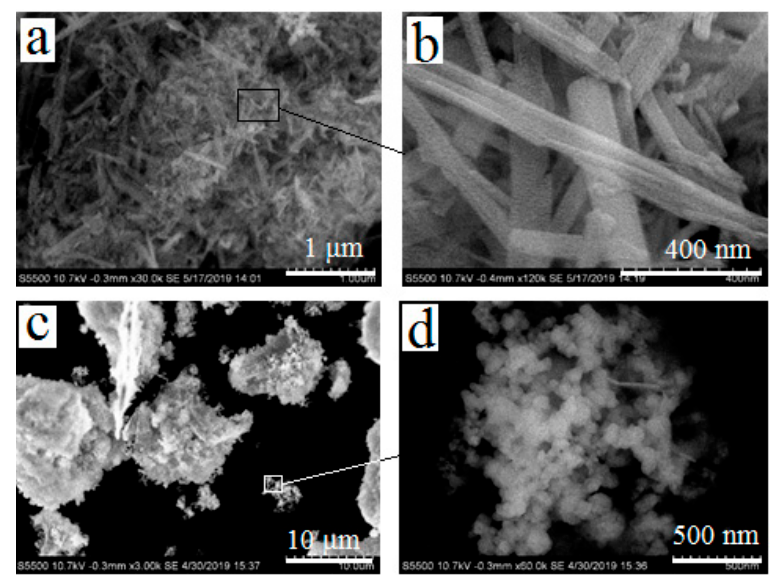
Figure 2. Powders of calcium silicate ( a , b ) and lead silicate ( c , d ) after drying at 85 °C. Magnifications: 30,000 × ( a ), 120,000 × ( b ), 3000 × ( c ), 60,000 × ( d ). According to the data obtained in [14], pseudowollastonite has the lowest integral solar absorption coe ffi cient in comparison with other forms of calcium silicate. Therefore, the temperature (1200 to pseudowollastonite.